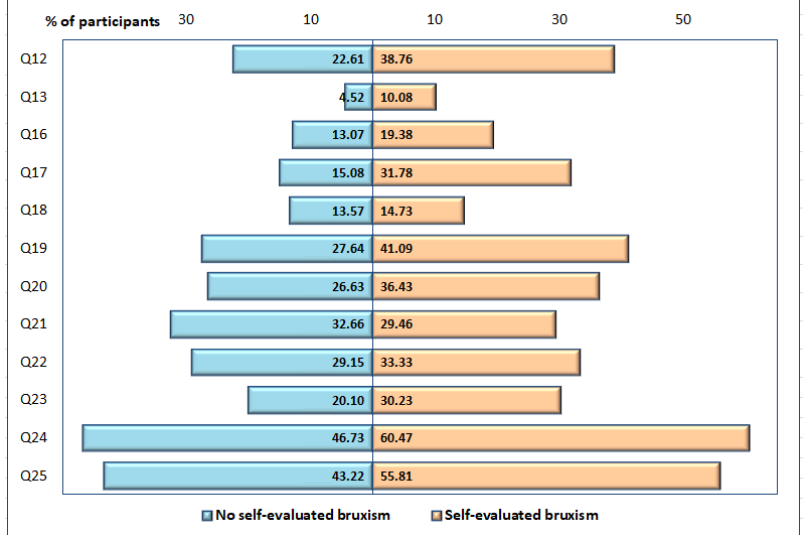
Figure 3. Distribution of participants (expressed as percentage) presenting clinical signs of stress: nervousness [Q12], tremor [Q13], strong heartbeats [Q16], tension [Q17], lack of satisfaction related to current occupation [Q18], DIS [Q19], DS (difficulties maintaining sleep) [Q20], waking up in the morning very early [Q21], EMA [Q22], restless sleep (for more than a month) [Q23], feeling tired (at least three days a week) [Q24], sleep deprivation (the need to sleep for more than one hour beyond current sleep duration) [Q25].